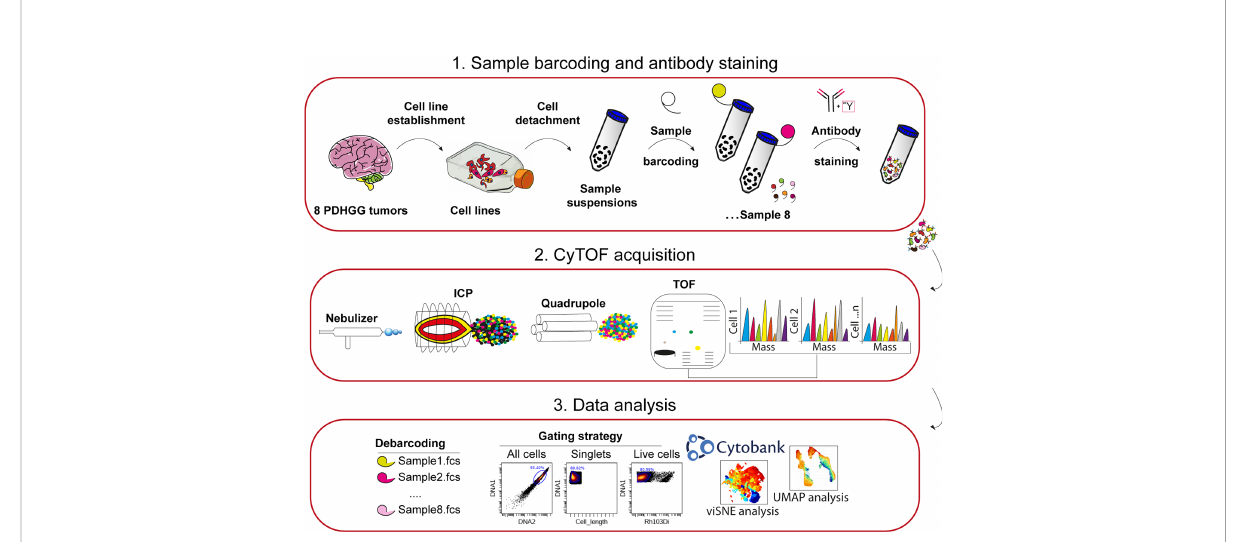
FIGURE 1 Experimental work fl ow adopted for single-cell mass cytometry analysis. 1. Eight PDHGG primary cell lines were established upon dissociation from tumor patients. After short expansion in stem-cell culture conditions, cells were detached for mass cytometry analysis. The different cell suspensions were barcoded with unique combinations of heavy metal tags and pooled together prior to staining with the selected metal-tag antibodies. 2. The cells were nebulized into a spray of single-cell droplets as they were introduced into the mass cytometer and atomized and ionized by the plasma (ICP). The resulting ion cloud was selected by the quadrupole for heavier reporter masses (>100 Da) which were pro fi led and quanti fi ed on their Time-Of-Flight (TOF). 3. Data were converted to.fcs fi le and further debarcoded and analyzed in the Cytobank environment, by employing the viSNE tool, and UMAP